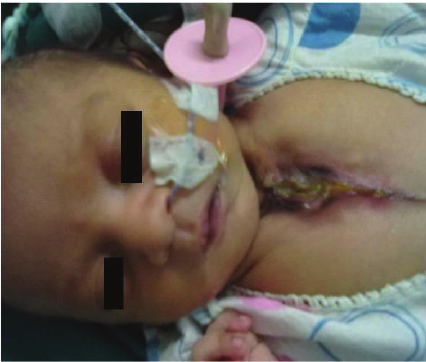
Figure 1: Preoperative appearance of the baby depression over chest wall.